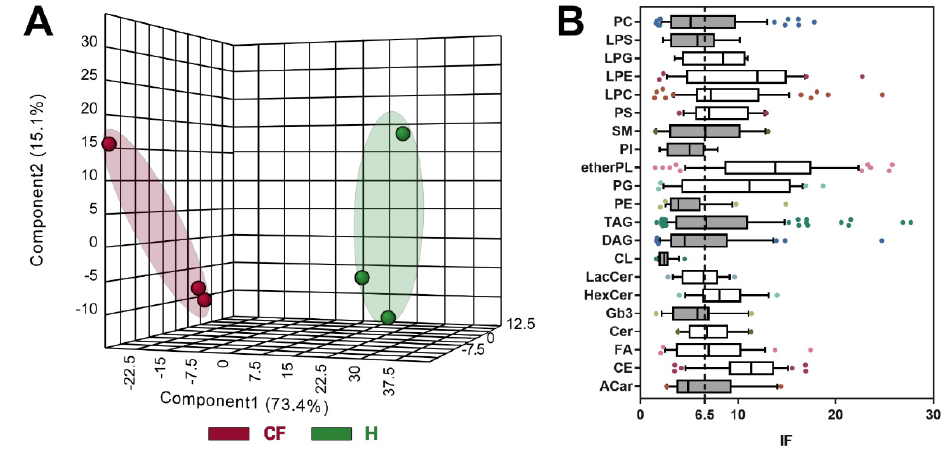
Figure 4. ( A ) Partial least squares discriminant analysis (PLS-DA) chemometric analysis. ( B ) Box and whiskers plots (line at median, and box stretched from the 25–75th percentiles; whiskers indicated the 10–90th, whereas outliers were plotted as single points) of the discriminant lipids ( n = 624) subdivided for lipid classes and evaluated by their IF scores (see Equation (3)). Grey boxes designated lipid classes that displayed an IF< cut-off (visualized as a dotted line and calculated as the lower confidence limit of the median of the features considered).